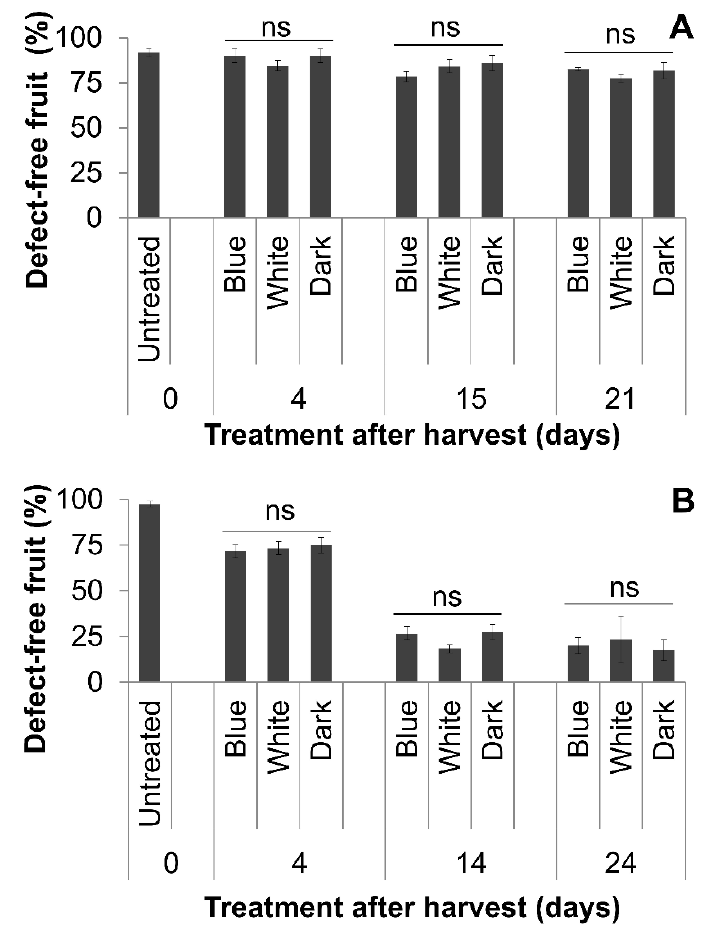
Figure 1. Percentage of defect-free fruit under different light treatments in ripe ‘Star’ ( A ) and ‘Alapaha’ ( B ) blueberries in cold storage. An initial fruit quality assessment was performed prior to treatment initiation (day 0). One-way analysis of variance was performed between the three treatments (blue, white and dark) separately for each time point after treatment. ns = non-significant (α = 0.05).